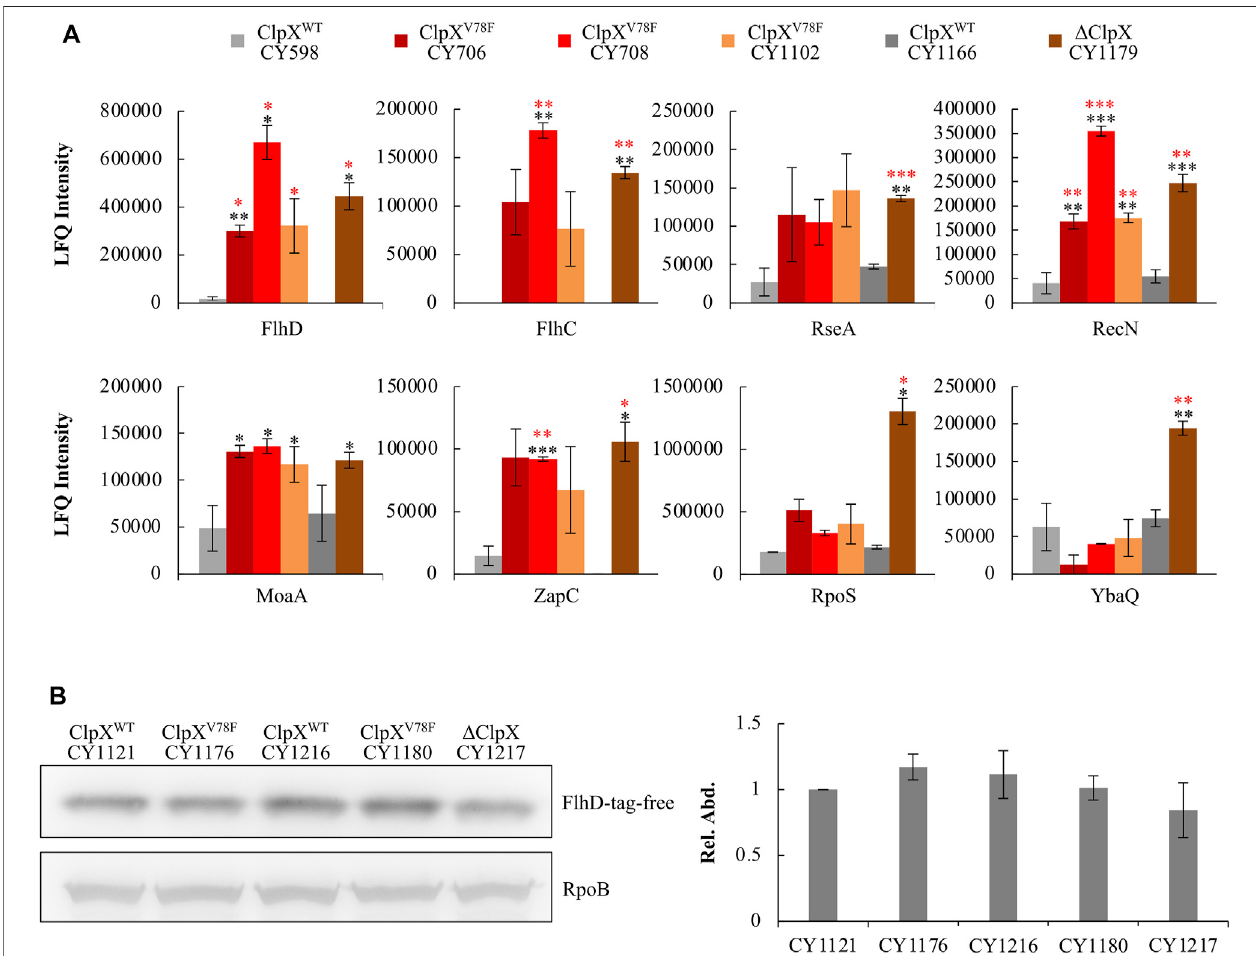
FIGURE 5 | Response of known ClpXP targets to the ClpX V78F mutation and identi fi cation of the speci fi c tag of FlhD recognized for ClpXP degradation. (A) Proteomic resultsshowingtheexpression ofproteins identi fi edtobedegradedbyClpXP proteaseinthesixstrains. Thedatawereexpressed asaverage ± S.E.M. ofthe two to three independent proteomic assays. * p ≤ 0.1, ** p ≤ 0.05, *** p ≤ 0.01 versus the expression of proteins by CY598 (black) or CY1166 (red). (B) The western blot result showing protein levels of the C-terminal tag deleted FlhD (FlhD-tag-free) in strains carrying ClpX WT , ClpX V78F , or deleted ClpX. Strains harboring the chromosomal FlhD-tag-free were individually derived from CY598 (ClpX WT ), CY708 (ClpX V78F ), CY1166 (ClpX WT ), CY1102 (ClpX V78F ), and CY1179 ( Δ ClpX). RpoB was usedasaloadingcontrol.Onerepresentativeresultofthewesternblotsisshown (leftplot). TheproteinlevelofFlhD-tag-freeinCY1121wasnormalizedto1,andthatin other strains was determined relative to this value. The relative protein level is shown as the average ± S.E.M. of the three independent experiments (right plot) .